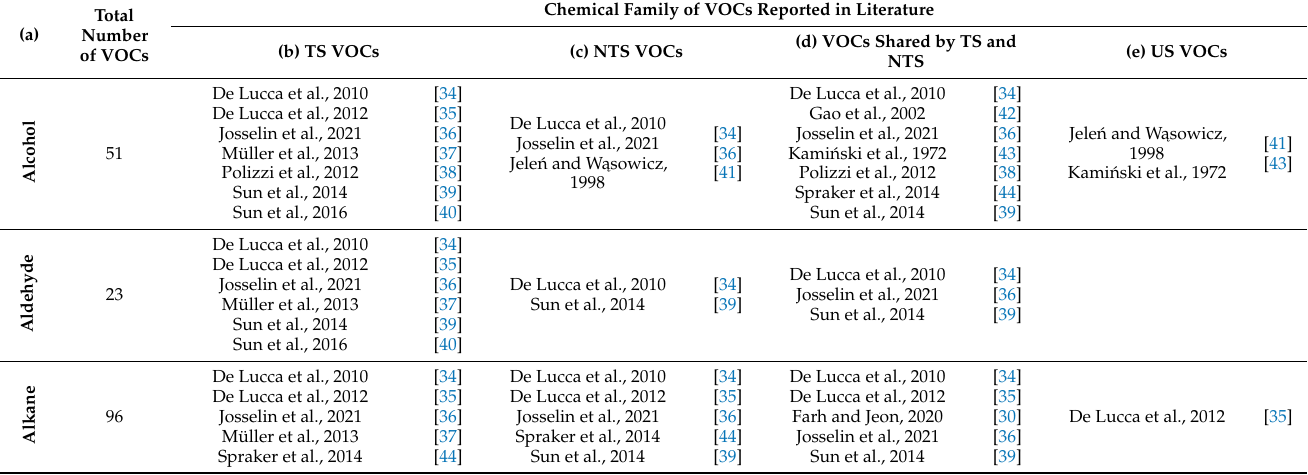
Table 1. Overview of literature references concerning the Volatile Organic Compounds (VOCs) emitted by A. flavus strains according to the chemical family of these VOCs and the ability of the A. flavus strains to produce AFB1 or